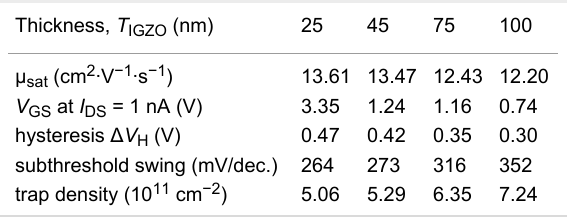
Table 1: The initial electrical properties of a-IGZO TFTs with various active layer thicknesses ( T IGZO ). Thickness, T IGZO